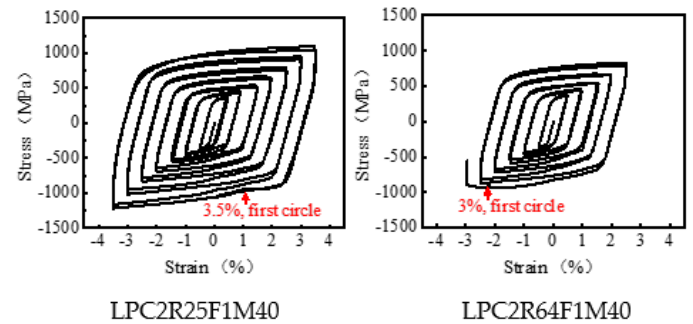
Figure 12. Hysteretic response curves of the proposed LPBRBs.